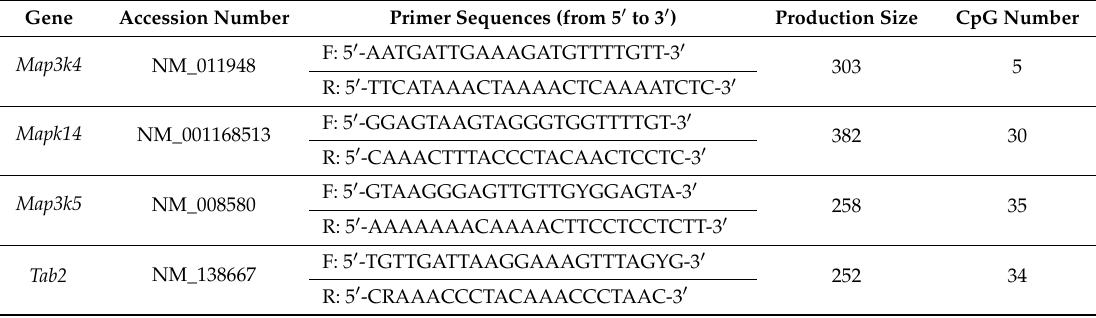
Table 1. PCR Primers for bisulfite sequencing.